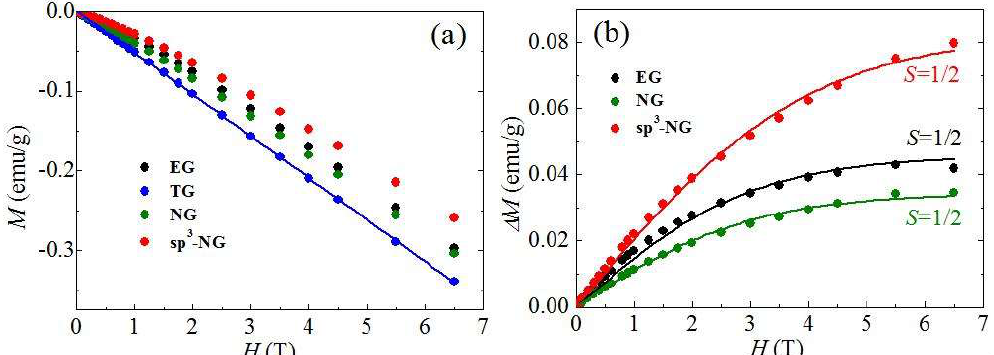
Figure 4. ( a ) Mass magnetization dependences on the applied magnetic field ( M – H ) of EG, TG, NG, and sp 3 -NG. The dots are the measurements and the blue solid line is linearly fit to the blue dots; ( b ) The dependences of mass magnetization of EG, NG and sp 3 -NG by subtracting which of TG on applied magnetic field ( ∆ M–H ). The solid lines are fit to Brillouin function with g = 2. The measurement temperature is 2 K.